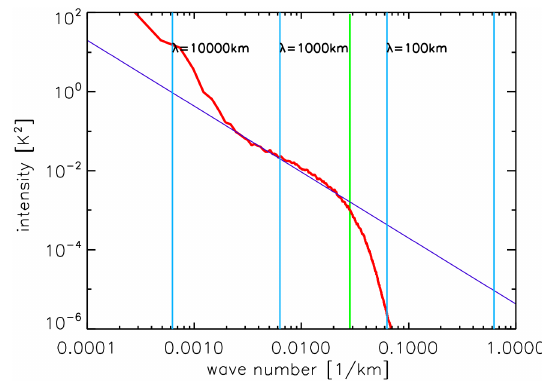
Figure 1. Power spectra of ECMWF temperatures in zonal direc- tion averaged over the period from 28 January to 3 February 2008 and over latitudes from 40 to 60 ◦ N. Altitude is 25km. The red line shows the average power spectral density in [K 2 km], the pur- ple line indicates a slope of − 5 / 3, the green line indicates the fit- by-eye where the spectrum becomes significantly steeper than the power-law, corresponding to a wavelength of ∼ 220km. Vertical blue lines are drawn for horizontal wavelengths of 10, 100, 1000 and